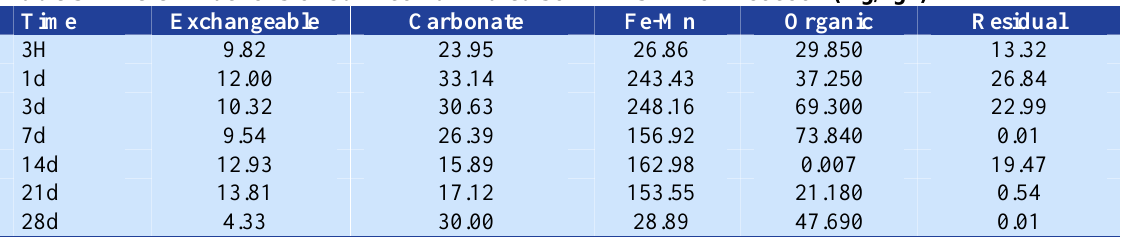
Figure 2. Different fractions of Cu in contaminated soil with silk worm cocoon (%) Table 3. Different fractions of Cu in contaminated soil with silk worm cocoon (mg/kg -1